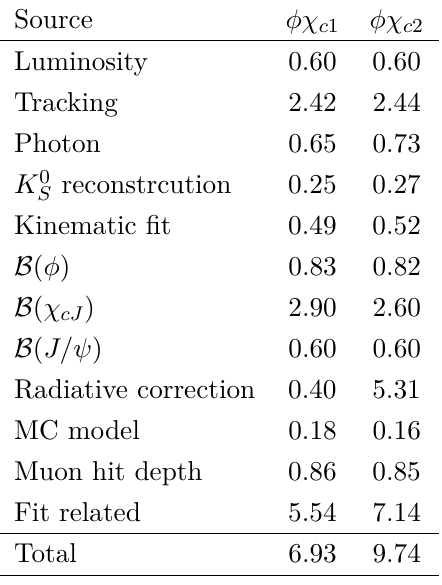
Table 6 . The systematic uncertainty sources and their contributions (in %) for the cross section of e + e − → φχ c 1 ,c 2 at 4.68